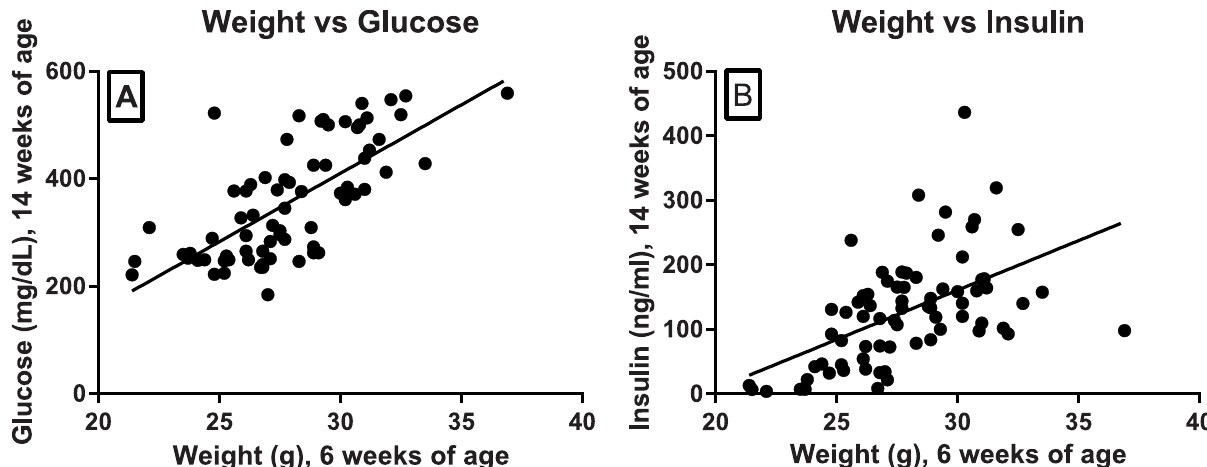
Fig 4. Weight correlated with glucose and insulin. Glucose (A) and insulin(B) levels at 14 weeks were plotted and analyzedaccordingto the animal weights at 6 weeks of age (weightvs glucose, r = 0.7033, p < .0001; weight vs insulin, r = 0.5317, p < .0001).